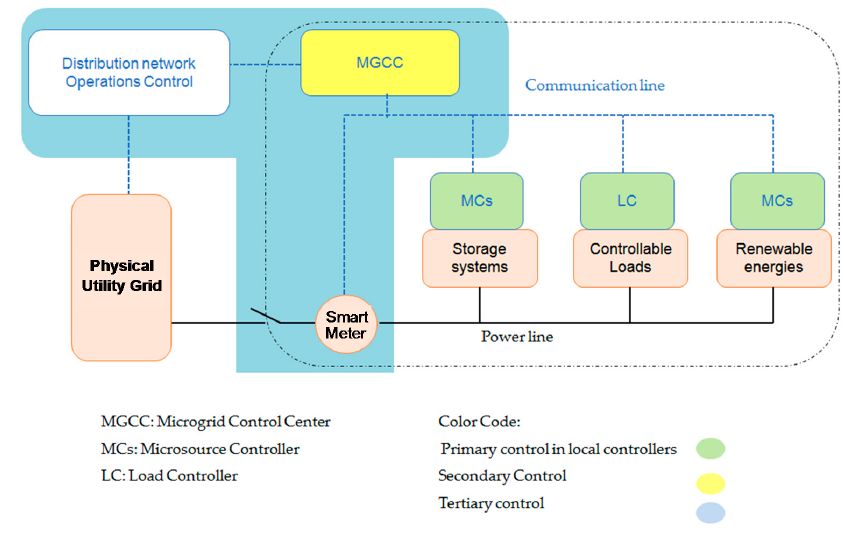
Figure 3. Modern basic structure of a microgrid.